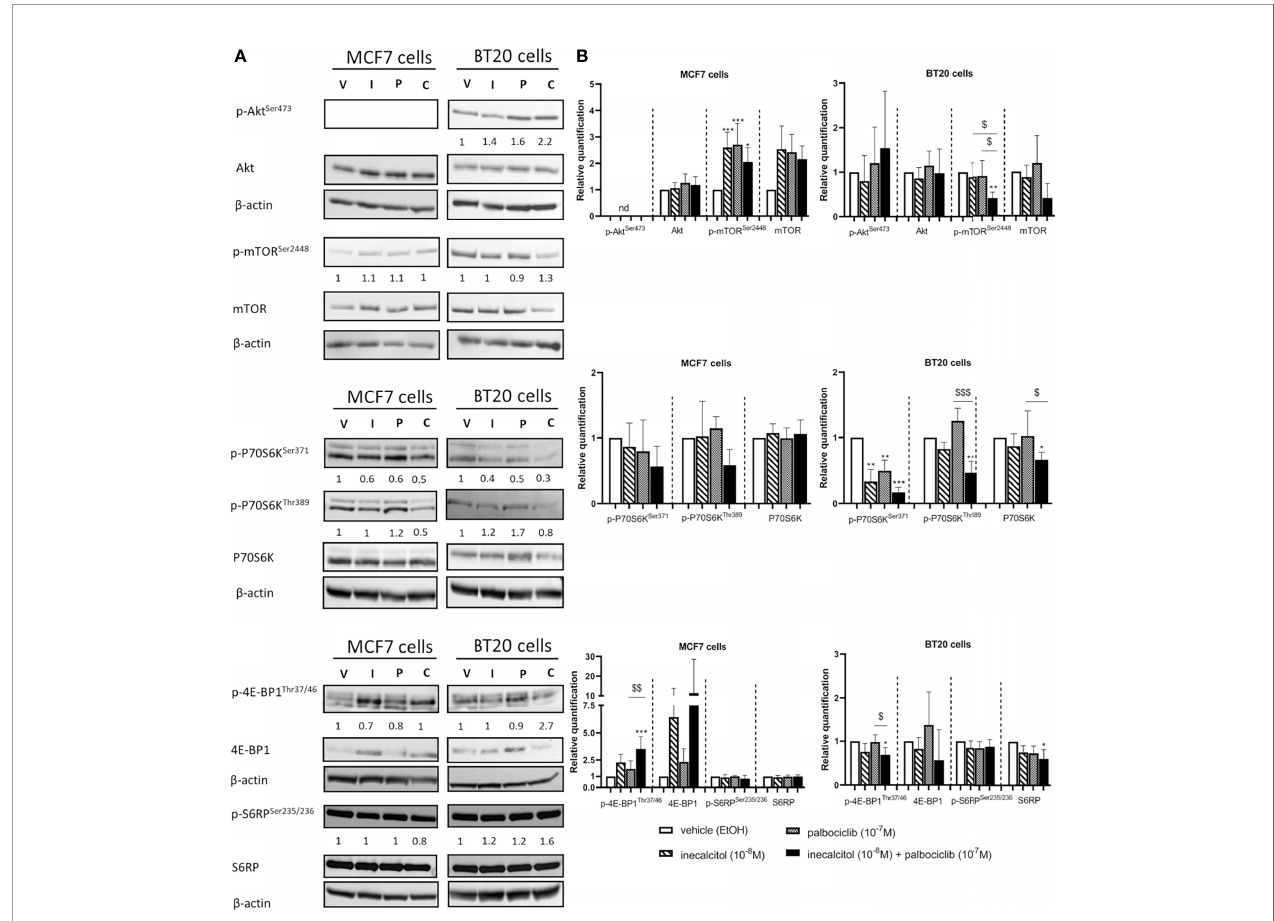
FIGURE 4 | Effect of inecalcitol and/or palbociclib treatment on PI3K/Akt/mTOR pathway. (A) Protein expression of (p)-Akt (60 kDa), (p)-mTOR (289 kDa), (p)-P70S6K (70-85 kDa), (p)-4E-BP1 (15-20 kDa), (p)-S6RP (32 kDa) in MCF7 and BT20 cells after 72 h of treatment (one representative blot is shown). The ratio of phosphorylated to non-phosphorylated relative protein expression is indicated under the representative blot. Data are expressed as fold increase vs control (control value = 1). (B) Relative quanti fi cation of protein levels of (p)-Akt, (p)-mTOR, (p)-P70S6K, (p)-4E-BP1, (p)-S6RP in MCF7 and BT20 cells (n= 3-7). b -actin (42 kDa) was used as loading control. V = vehicle (EtOH), I = inecacitol (10 -8 M), P = palbociclib (10 -7 M) and C = combination of inecalcitol (10 -8 M) and palbociclib (10 -7 M). Data shown as mean ± SD. ndthe not detected. *p ≤ 0.05; **p ≤ 0.01; ***p ≤ 0.001 compared to vehicle; $ p ≤ 0.05; $$ p ≤ 0.01; $$$ p ≤ 0.001 compared to inecalcitol or palbociclib monotherapy (one-way ANOVA, Sidak ’ s multiple comparison